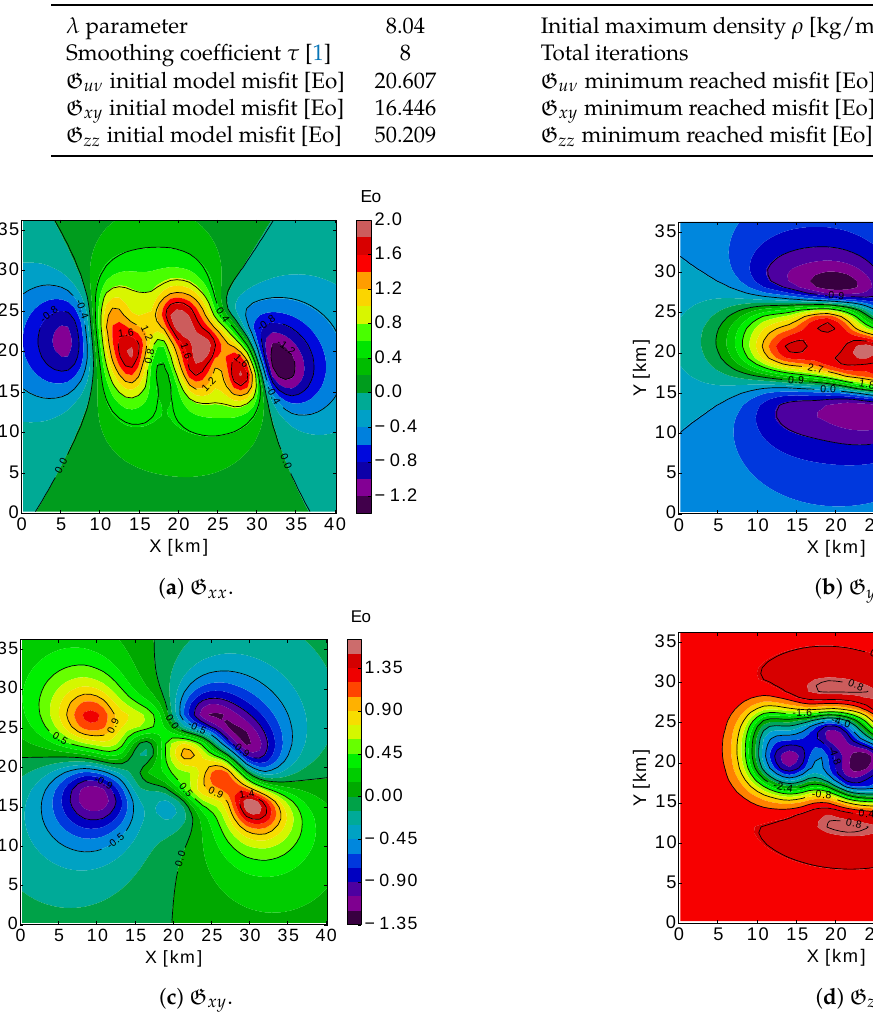
Figure 32. Initial (colour map) and inverted (contour lines) gradiometric response for the salt body.